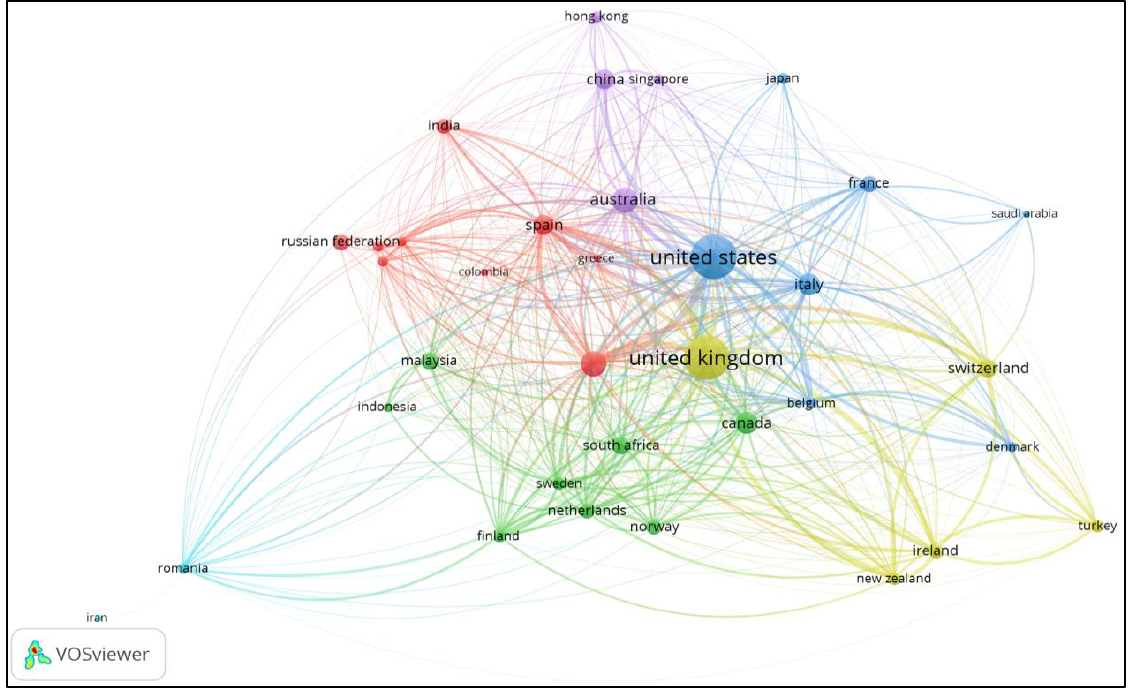
Figure 5. Country-wise published reputation risk papers